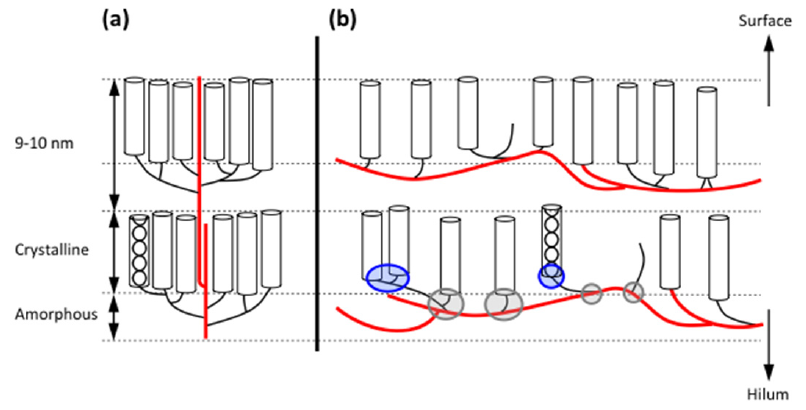
Figure 4. Amylopectin in the semi ‐ crystalline growth ring depicted based on the cluster model ( a ) or the building block backbone model ( b ). The crystalline and amorphous lamellae are indicated by dotted grey lines. Long B ‐ chains (thick red lines) and short chains (black lines) are shown. The backbone in ( b ) carries internal building blocks (some encircled in grey) and can also carry short BS major ‐ chains that form branches to the backbone and connect to external building blocks (encircled in blue). Cylinders symbolise double ‐ helices formed by external chains. Single chains introduce defects in the crystalline lattice. The directions toward the surface and the hilum of the granule are indicated at the right.